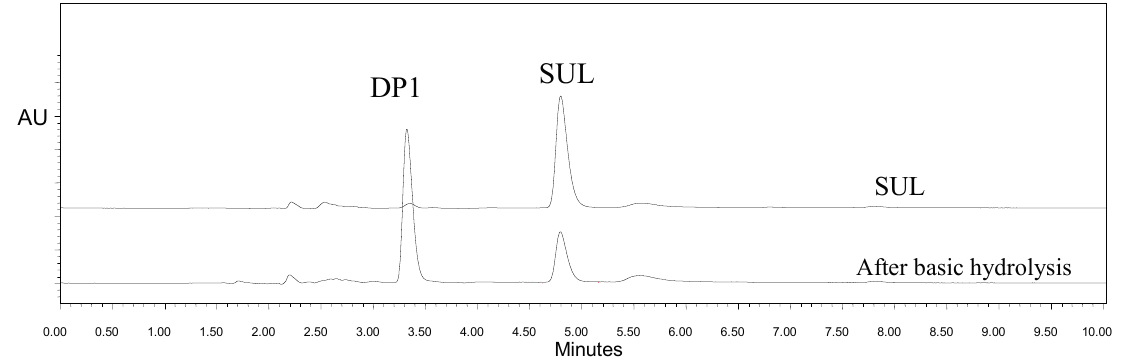
Figure 2. Chromatograms of sulfentrazone (SUL) before (Standard) and after being subjected to stress by basic hydrolysis, emphasizing product formation by cleavage of the lactone ring